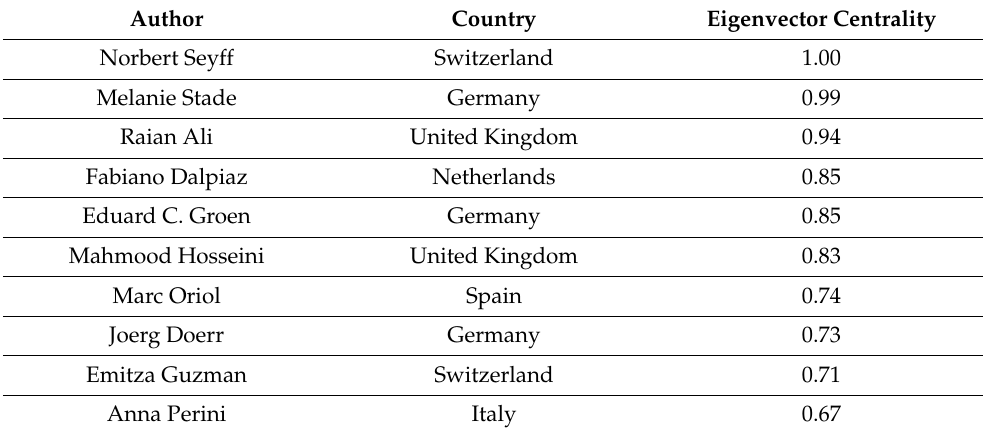
Table 9. Eigenvector centrality of authors in the CSE co-authorship network.